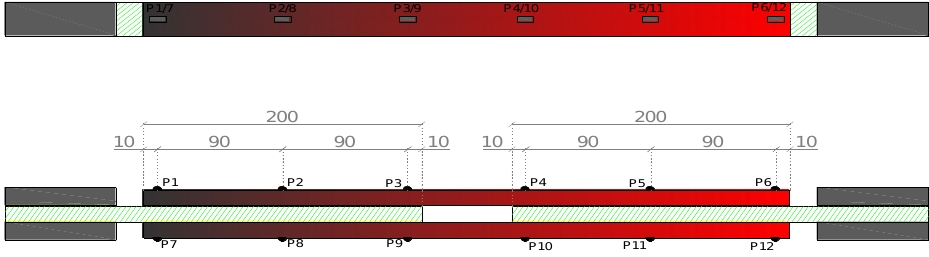
Figure 6. Strain gauge positions (bottom/top and side view).